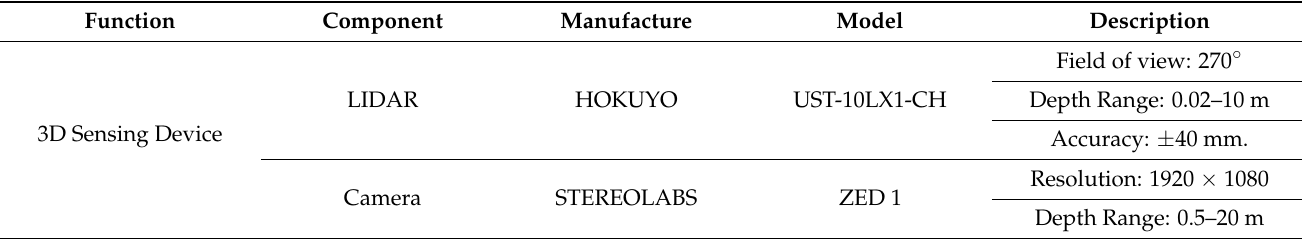
Table 1. Specifications of the proposed dump truck 3D position recognition